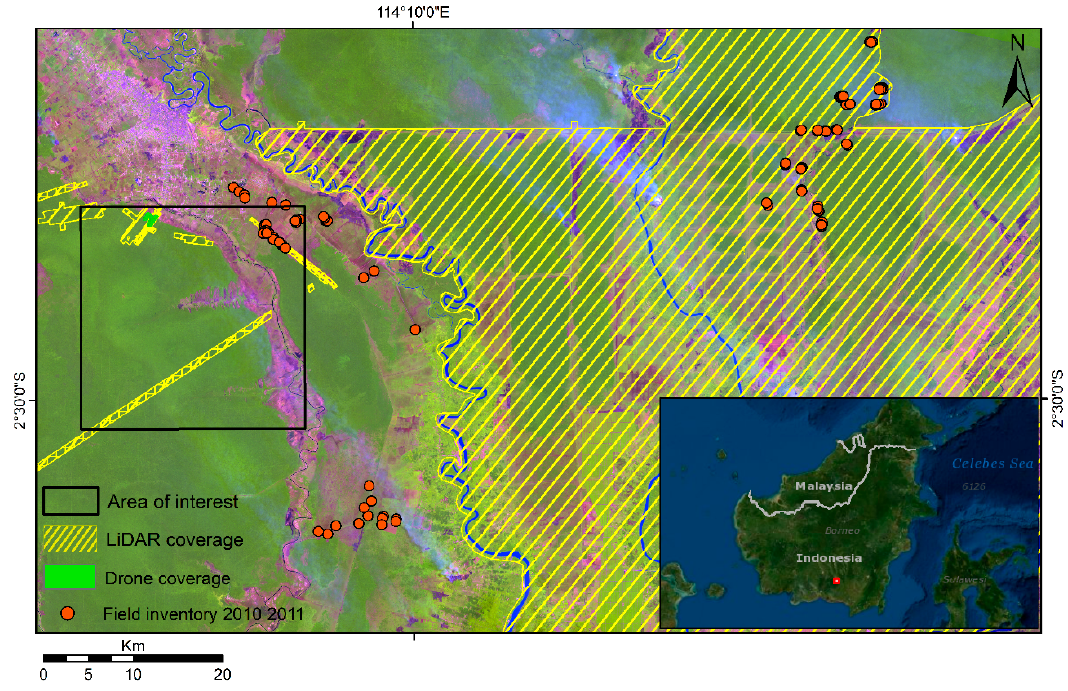
Figure 1. RGB composite of Landsat-8 (short-wave infrared, near-infrared, red) from 2015 showing the location of the area of interest including the field plots from 2010–2011 and the LiDAR (2011) and UAV (2016) coverage.